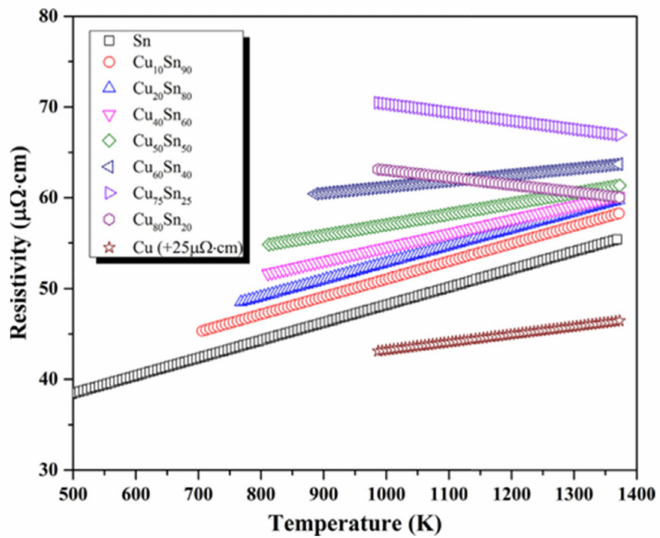
Figure 13. Temperature versus resistivity curve for liquid Cu-Sn alloys with a cooling rate of 5 K/min